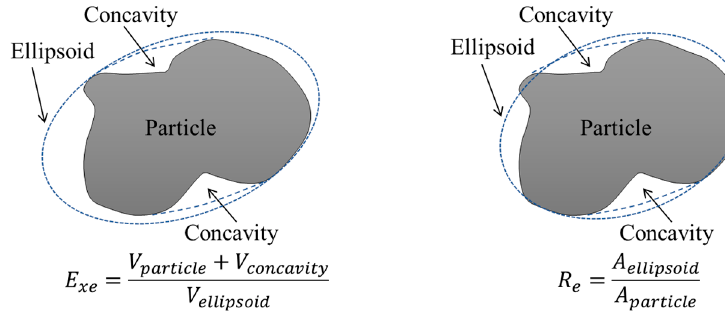
Figure 6. The diagrams illustrating the calculations of form, roundness, and surface roughness in- dices. Table 3. Calculation results of typical shape indices of selected particles.